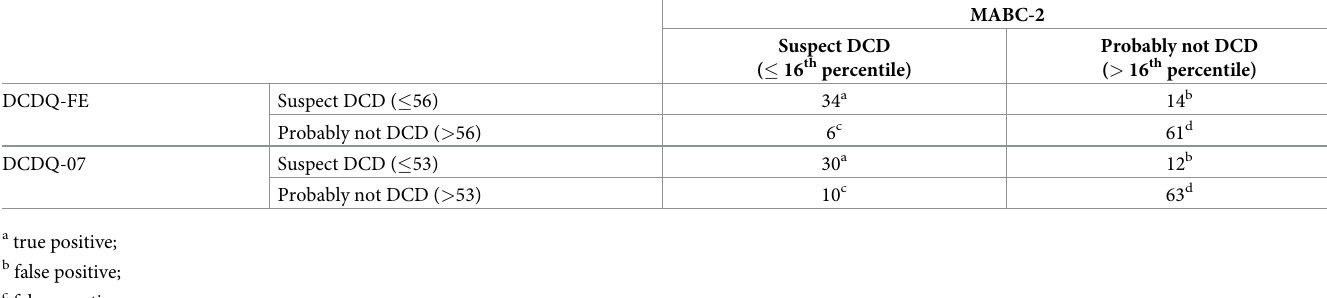
Table 5. Classification of DCD with the MABC-2 ( < = 16 th percentile) using the DCDQ-FE and DCDQ’07 cut-off scores (n =